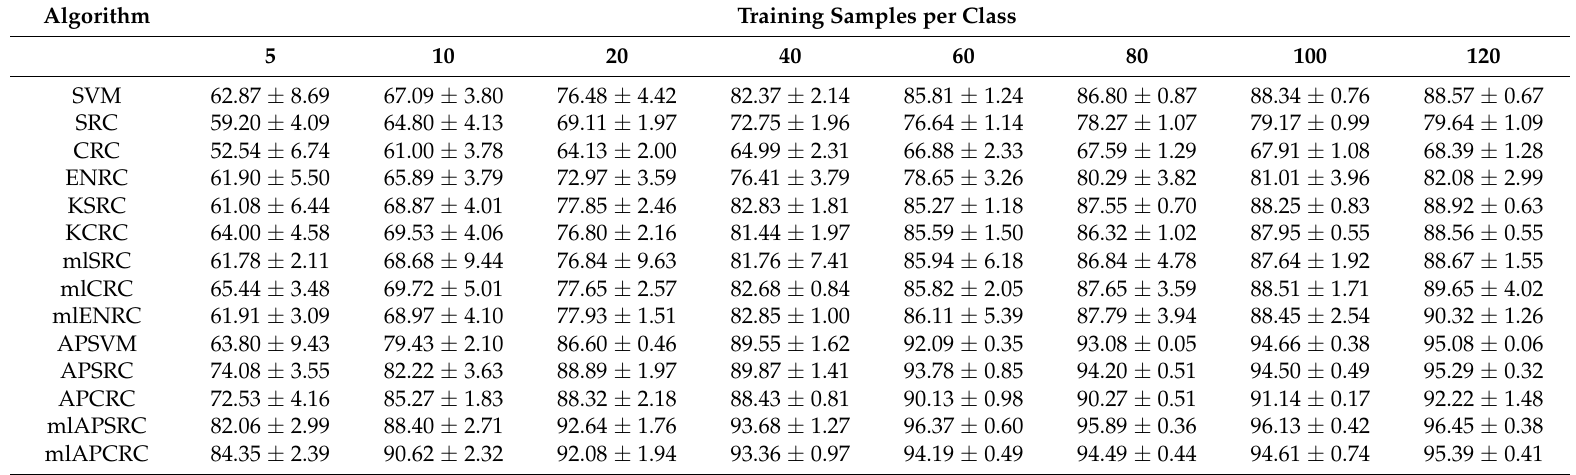
Table 5. Overall classification accuracy (%) and standard deviation as a function of the number of training samples per class for the University of Pavia image. Algorithm